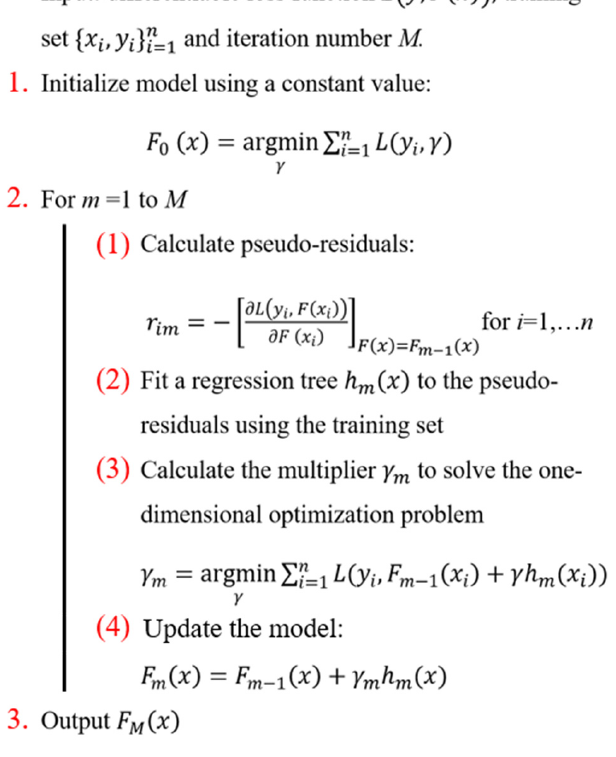
Figure 7. Pseudocode of GBRT [80].